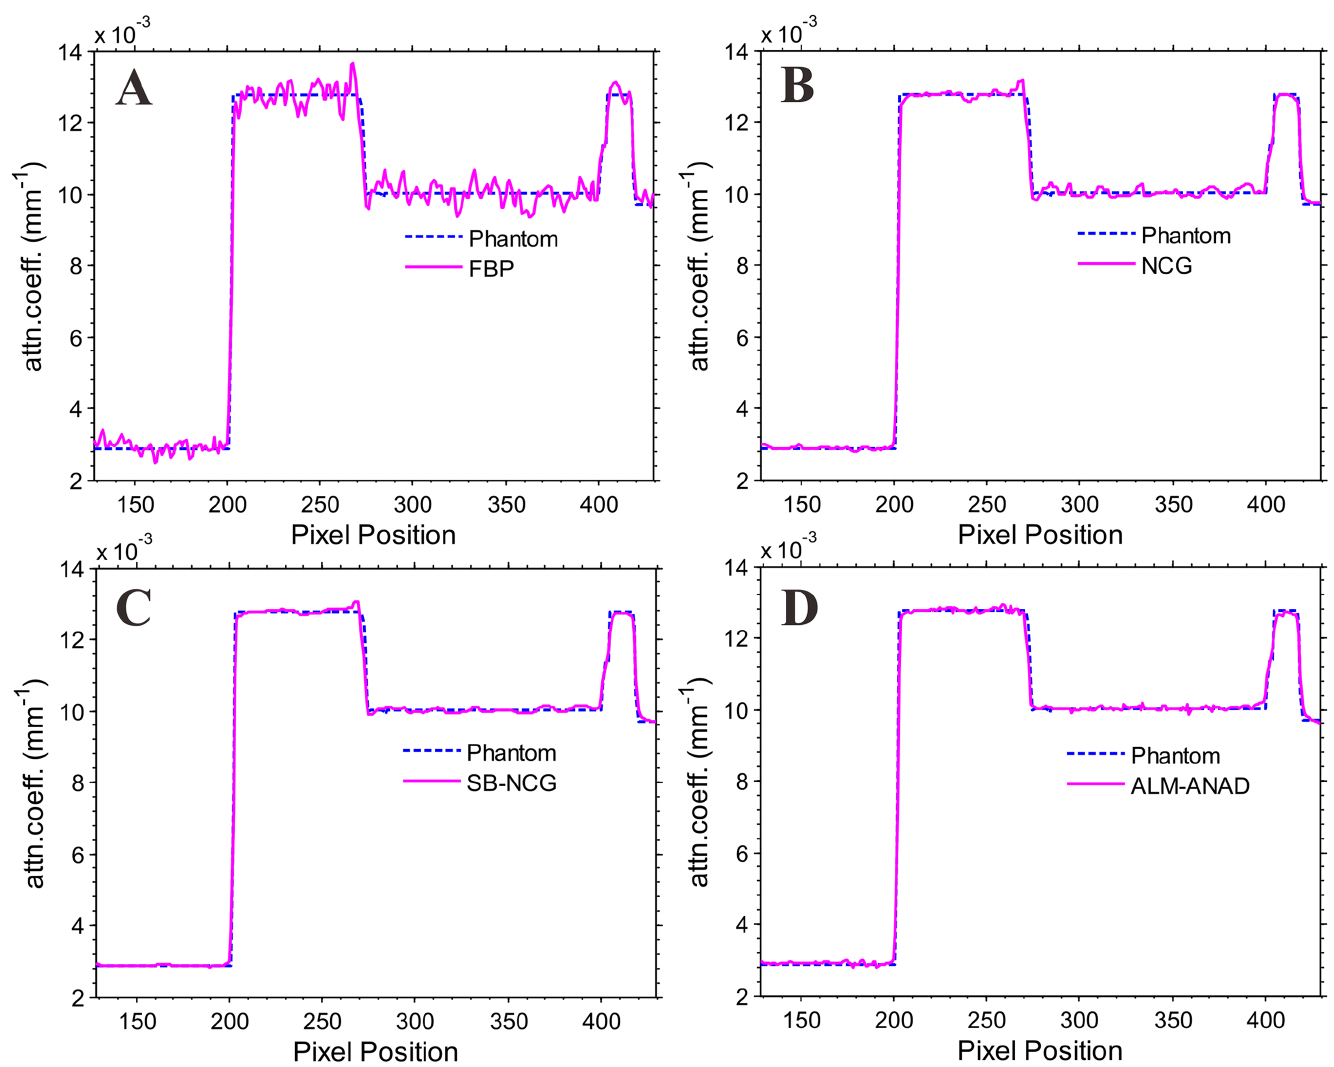
Fig 3. Vertical profiles (296 th column) of the images reconstructed from different algorithms. (A) is the result from the FBP algorithm with ramp filter; (B) is the result from the NCG algorithm; (C) is the result from the SB-NCG algorithm; and (D) is the result from ALM-ANAD algorithm. The ‘ dashed line ’ in each sub-figure denotes the profile from the true phantom.